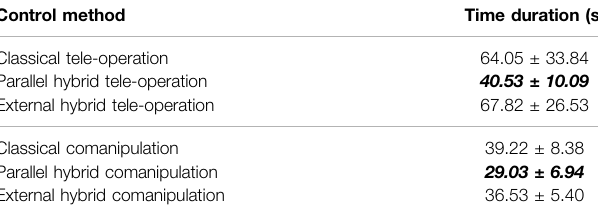
TABLE 2 | Time required to achieve the task with different control